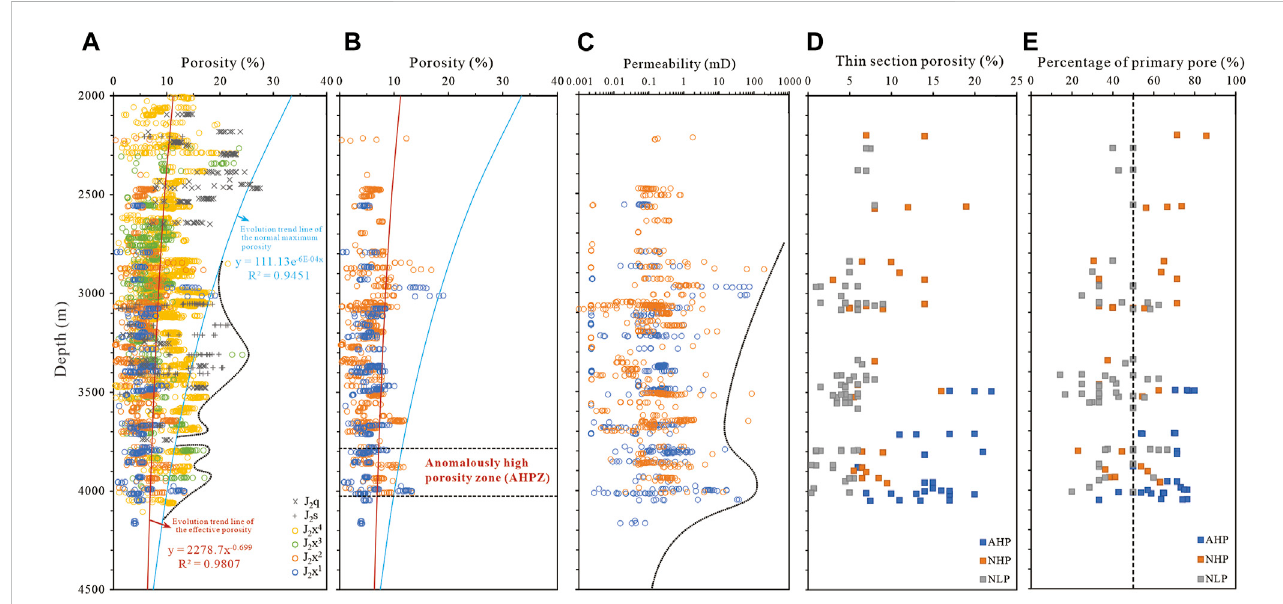
FIGURE 3 The buried depth versus (A) core porosity of middle Jurassic sandstones, (B) core porosity of J 2 x 1+2 sandstones, (C) core permeability of J 2 x 1+2 sandstones, (D) thin section porosity of different types of reservoirs, and (E) percentage of primary pore in different types of reservoirs in the Taibei